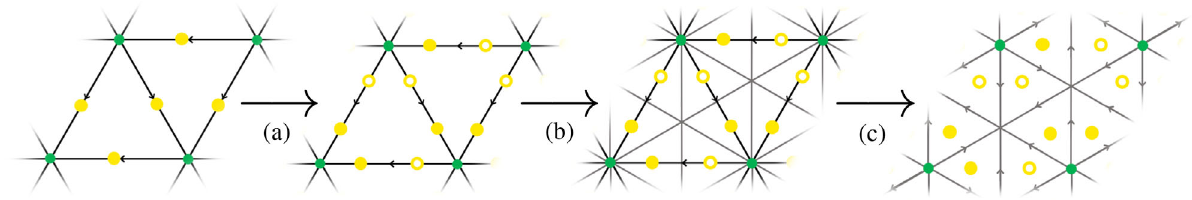
FIG. 16. Far left: The beyond-supercohomology models in Ref. [39] have G d.o.f. (green dots) at vertices and a single complex fermion d.o.f. (yellow dots) at each link. (a) We add an additional complex fermion d.o.f. (hollow yellow circle) to each link and modify the Hamiltonian by adding a term that enforces zero fermion occupancy at each of these additional sites. (b) We add links to the lattice to form the barycentric subdivision of our original triangulation. (c) The links of the original lattice are removed in the bulk and we associate one complex fermion to each triangle of the resulting lattice. The branching structure is determined by the branching structure of the original lattice. Importantly, the final Hilbert space has a single complex fermion d.o.f. for each triangle. Note that the G d.o.f. remain in